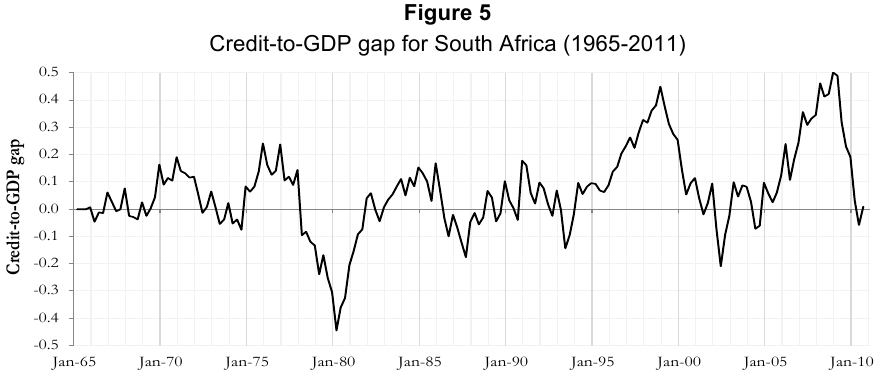
Credit-to-GDP gap for South Africa